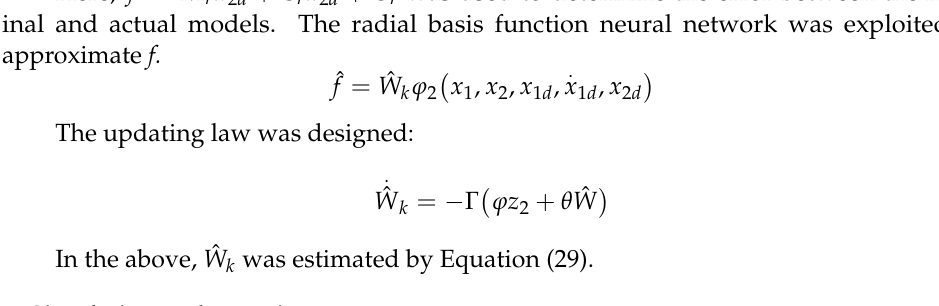
Figure 9. Tracking error.